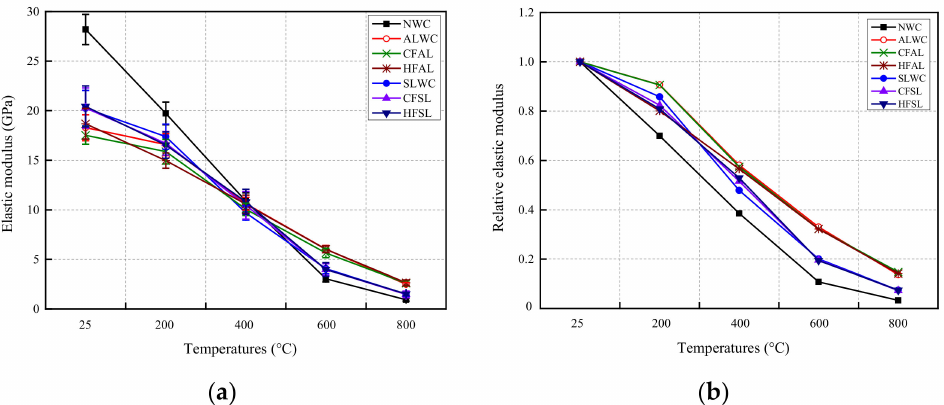
Figure 10. Temperature effect on the elastic modulus: ( a ) absolute elastic modulus; ( b ) relative elastic